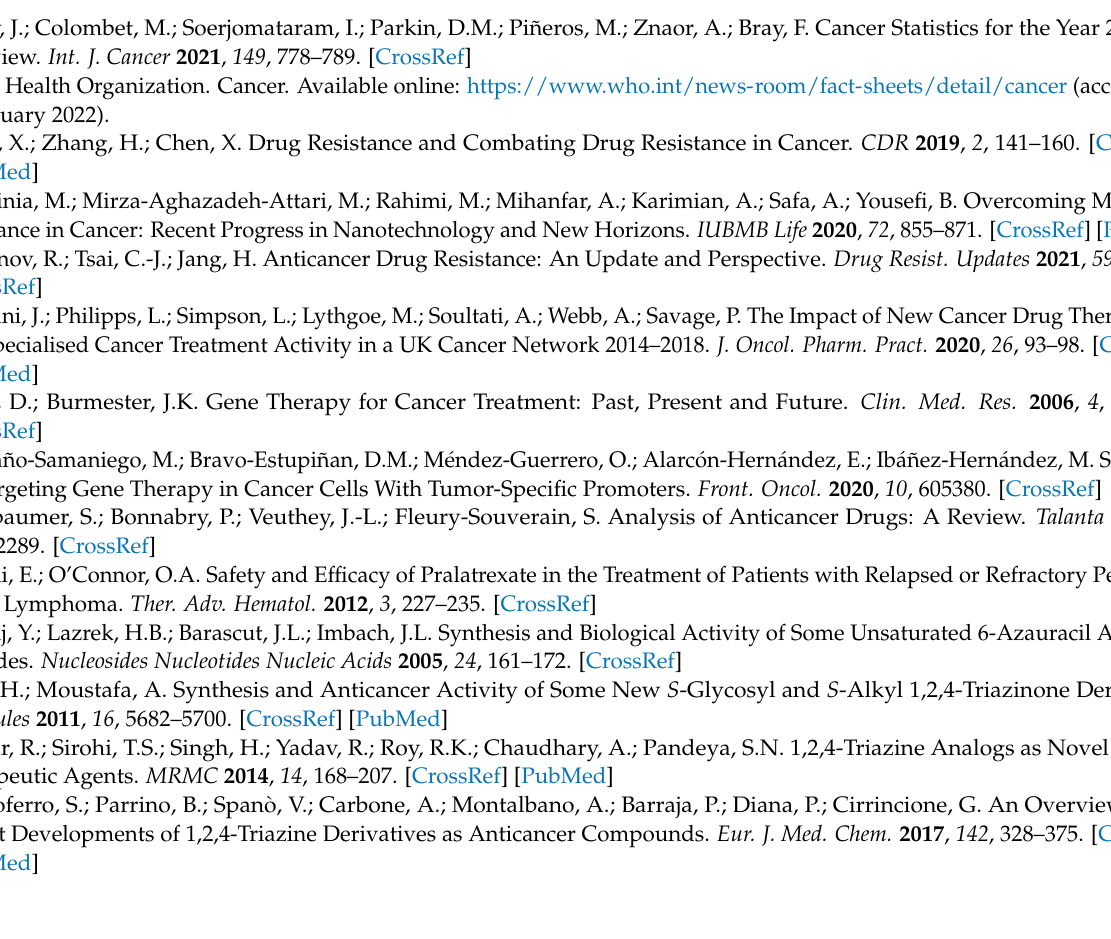
1H NMR in MeOH-d4 for derivative MM129 ; Figure S14: 13C NMR in MeOH-d4 for derivative MM129 ; Figure S15: 1H NMR in CDCl3 for derivative MM129 ; Figure S16: 1H-NMR in MeOH-d4 for derivative MM130 ; Figure S17: 13C NMR in MeOH-d4 for derivative MM130 ; Figure S18: 1H-NMR in MeOH-d4 for derivative MM131 ; Figure S19: 13C-NMR in MeOH-d4 for derivative MM131